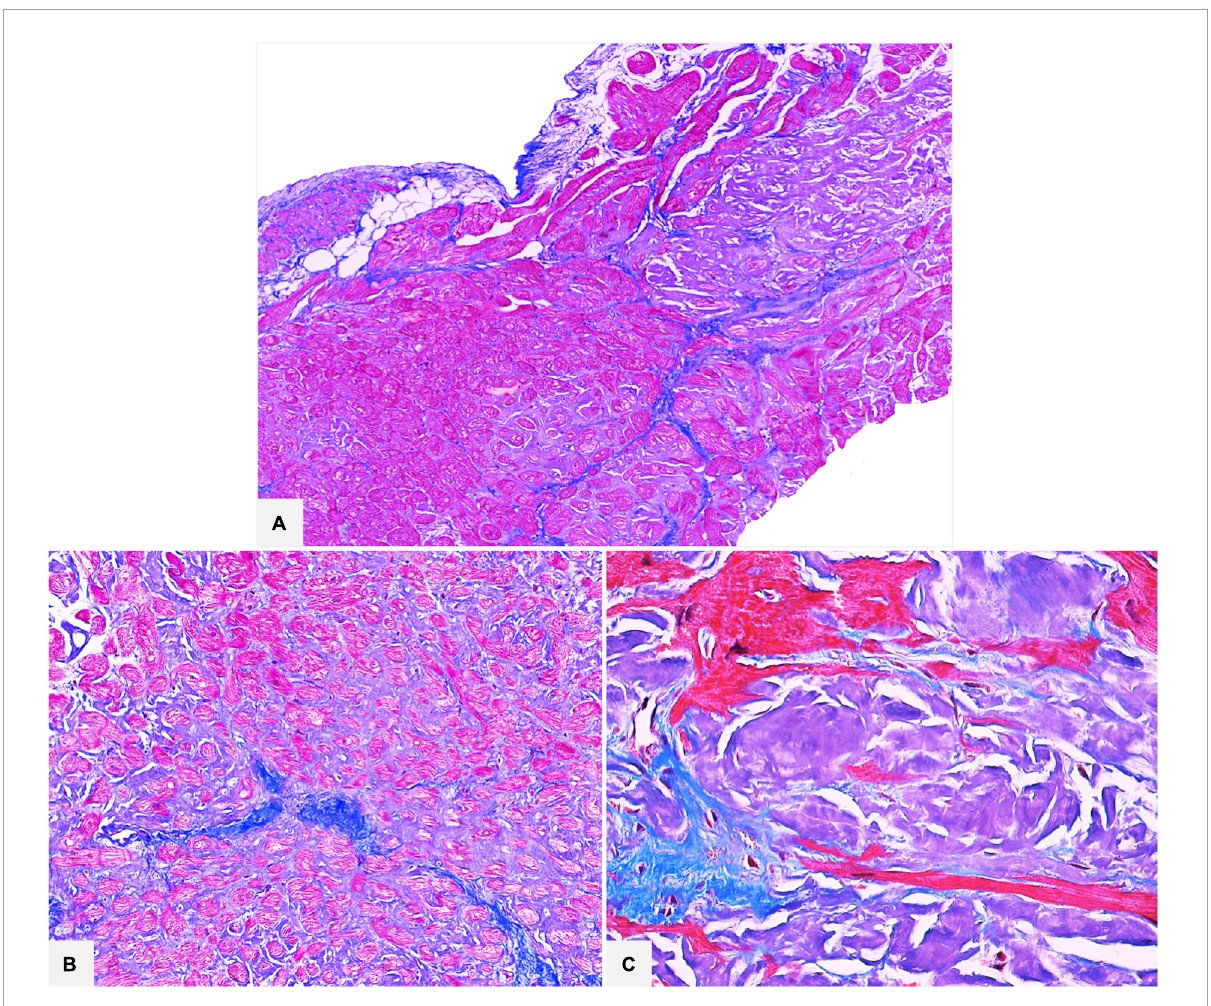
FIGURE3 Cardiac specimens from native hearts of patients transplanted for ATTR. The myocardial interstitial pericellular and nodular amyloid deposits are stained bluish-gray with Azan Mallory trichrome and are clearly distinguishable from the brilliant blue collagen deposition ( A: 50 × ; B: 100 × ; C: 400 ×